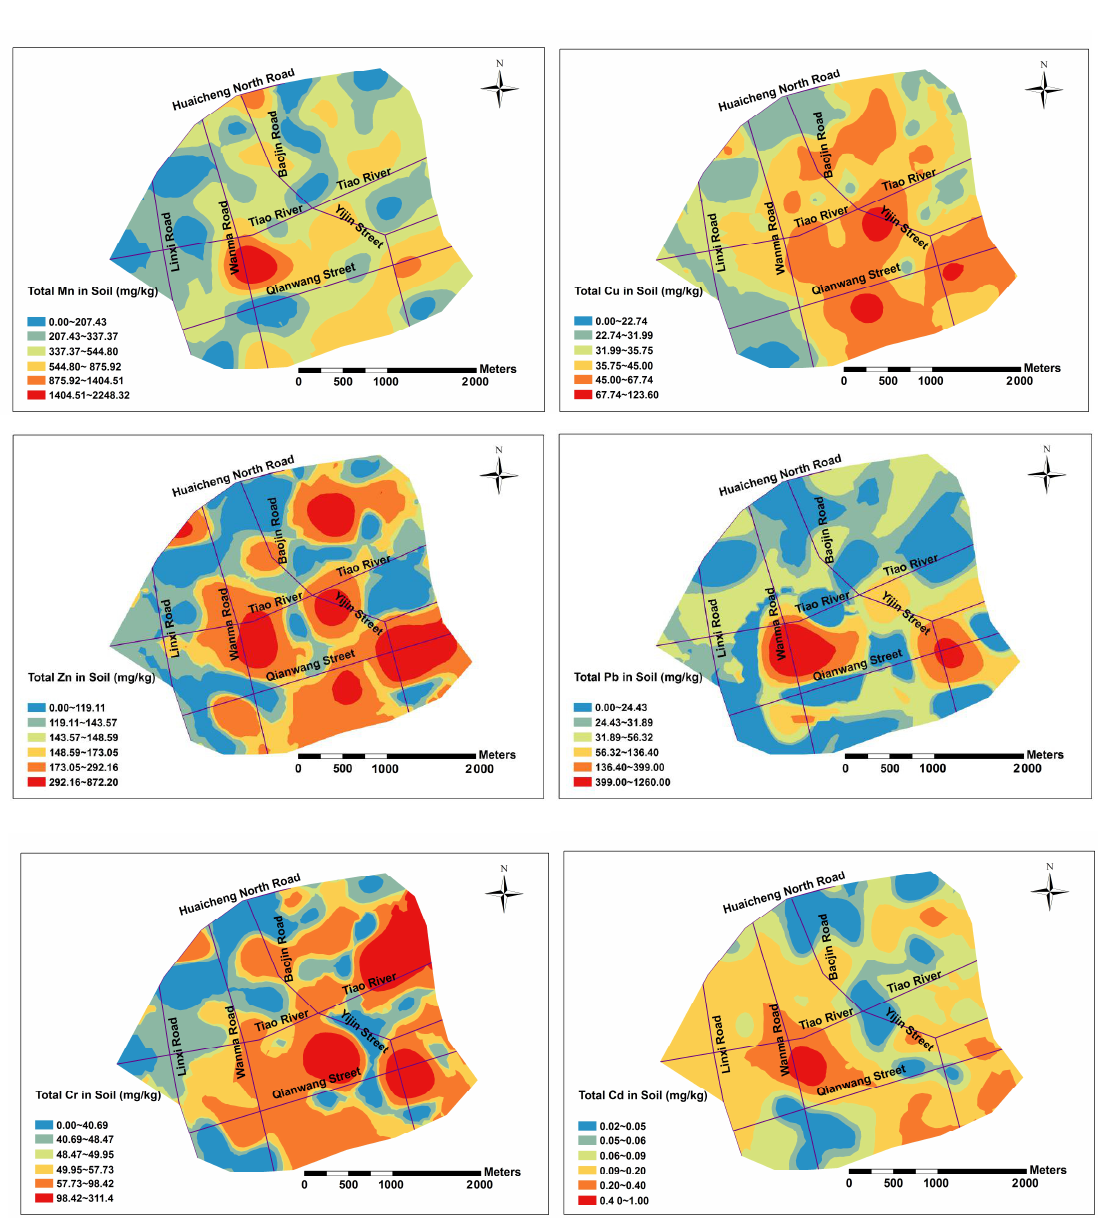
Figure 2. Spatial distribution maps of the total PHMs.